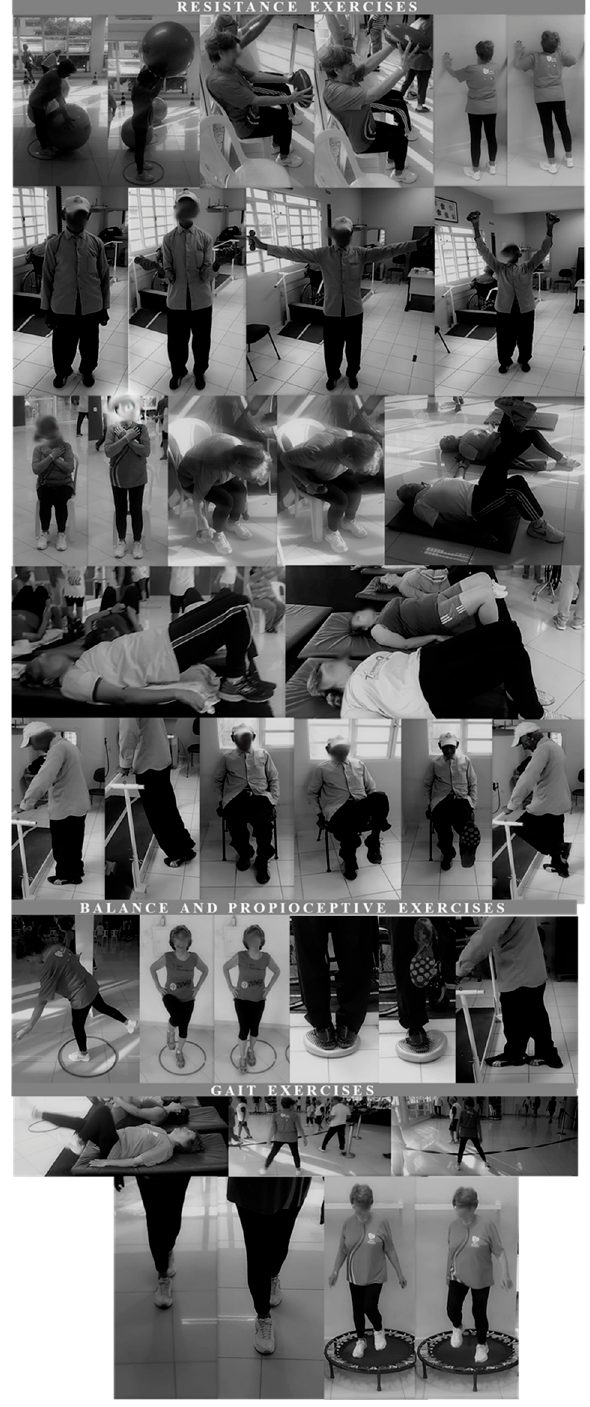
Figure 1. Representation of the resistance, balance/proprioception, and gait exercises used in the present MCEP.